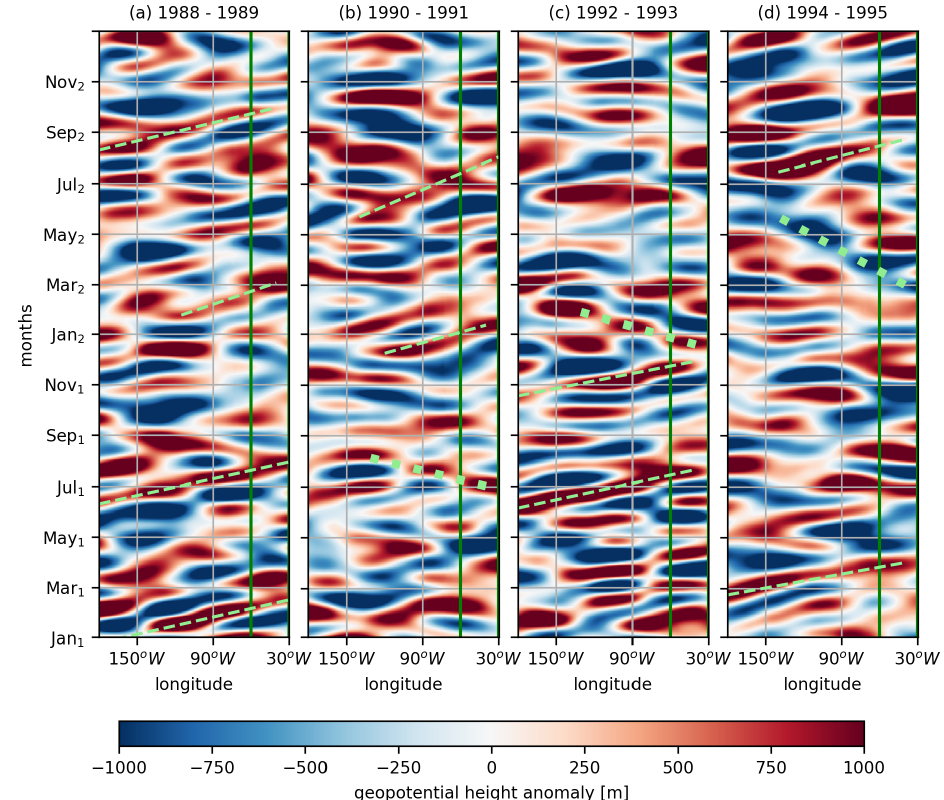
Figure 11. Hovmöller diagram of the filtered Z 200 anomaly signal from 1988 to 1995 and retains the variability within 30–185d with a Lanczos bandpass filter. The green line indicates the longitudes corresponding to the wSA. The subscript 1 (2) in the month labels corresponds to the first (second) year indicated in the title of each